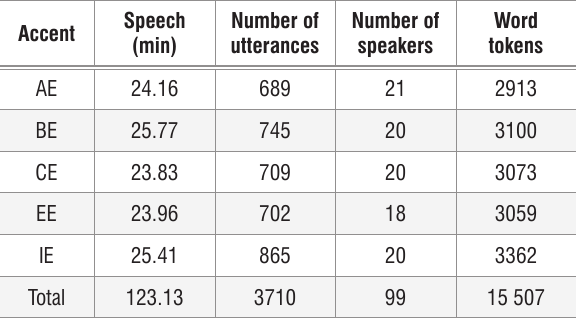
Table 2: Evaluation sets for each South African English accent